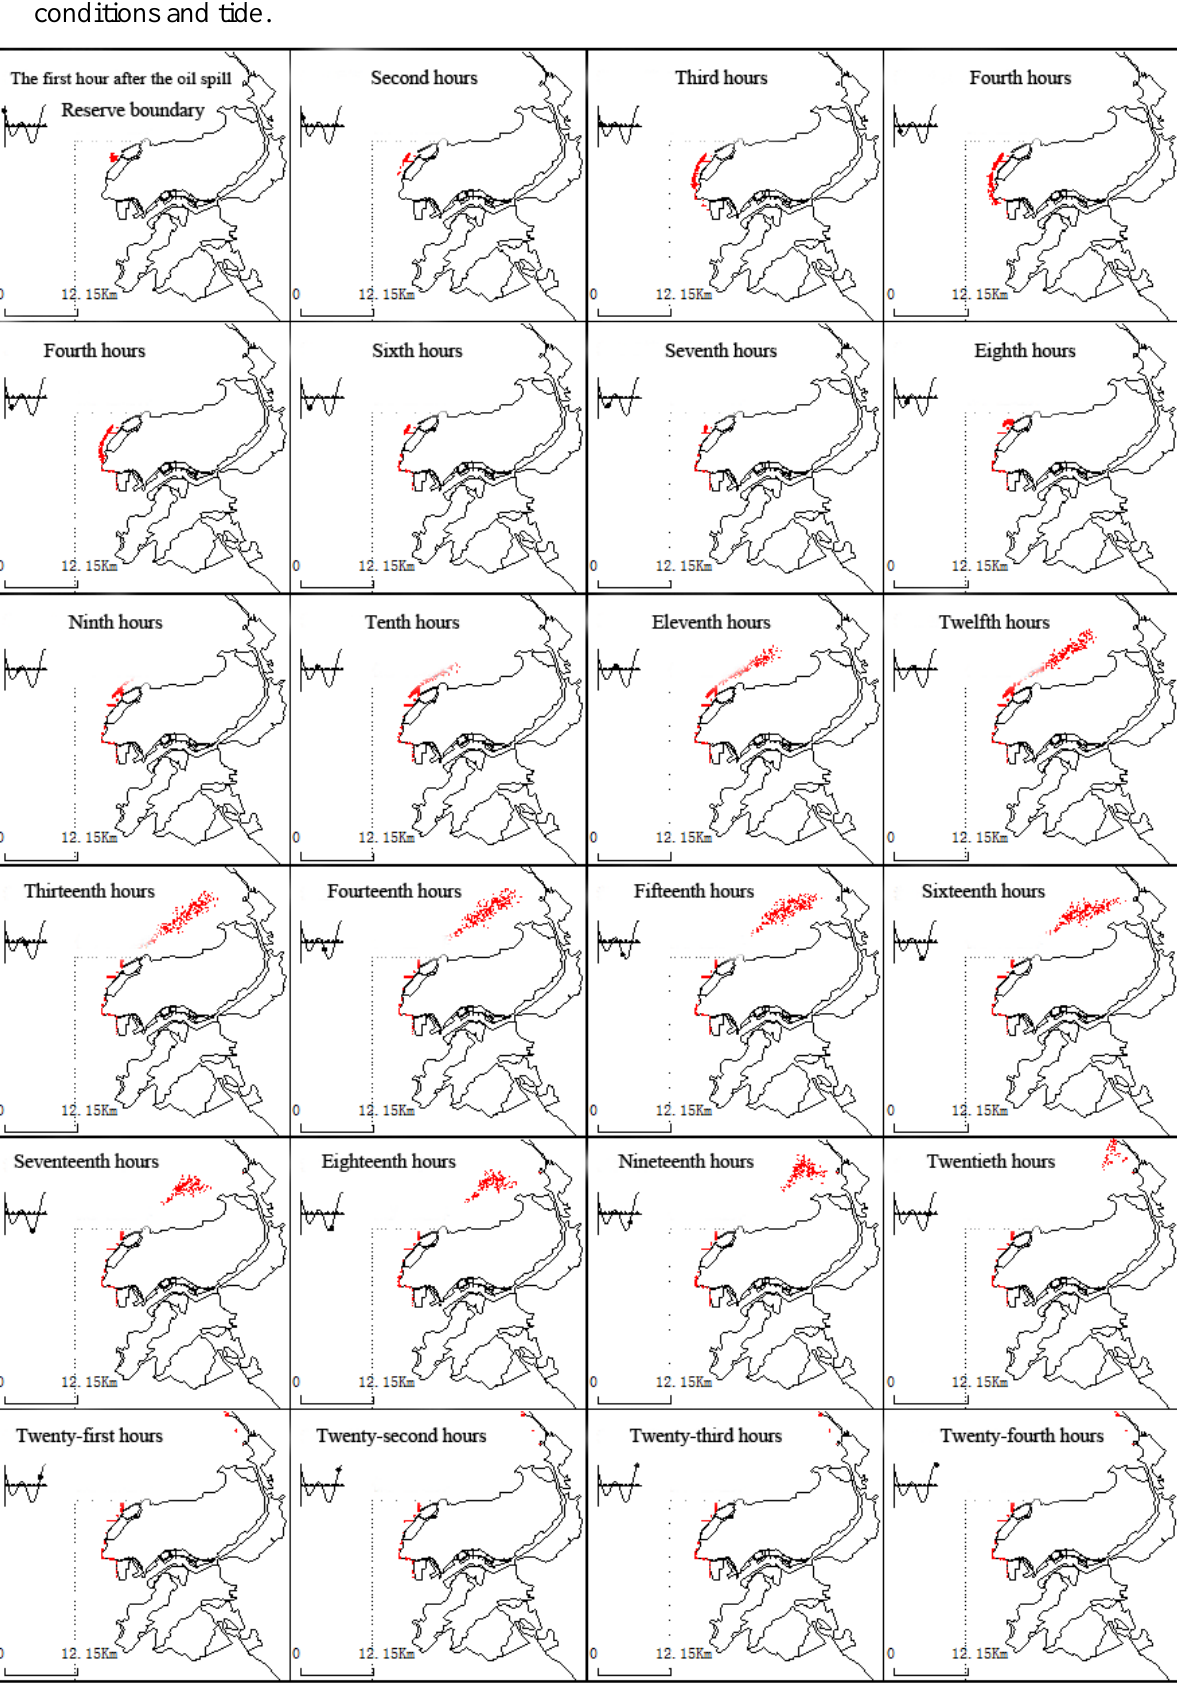
Figure 4. The dynamic changes of the oil film under continuous drift and WSW wind conditions and